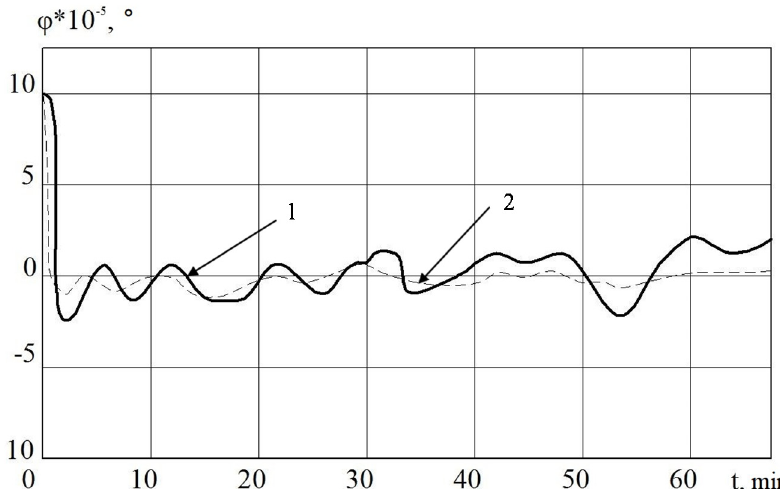
Figure 6. The deviation angle of the GSP in INS from the horizon plane when using a measuring complex (MC) with a regulator (1) and a non-linear SDC regulator (2).